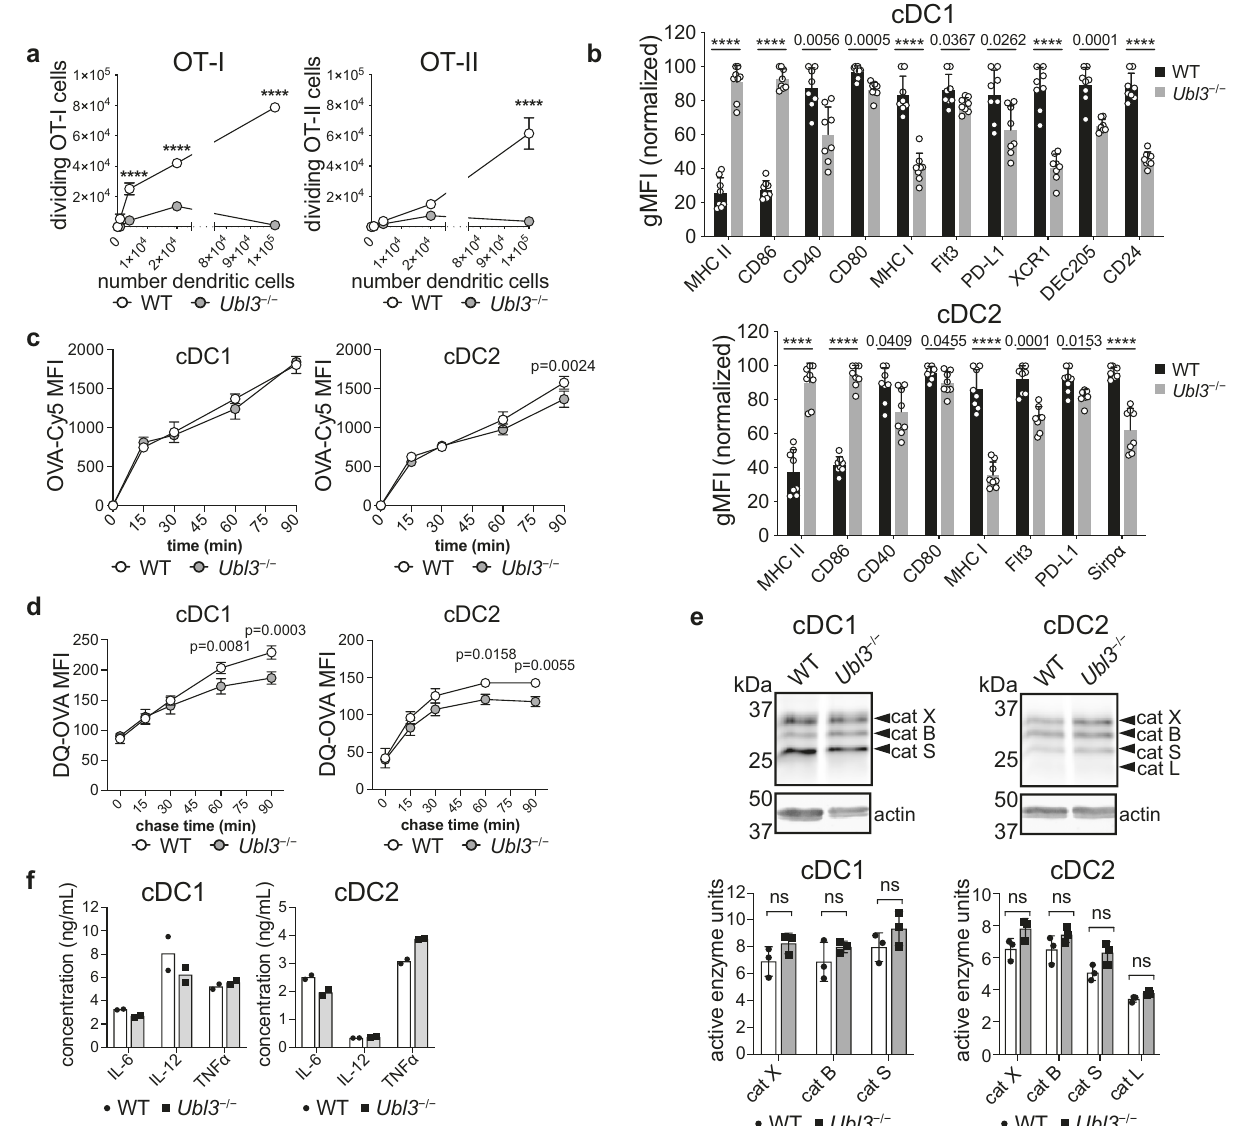
Fig. 7 Lack of UBL3 alters cDC function and phenotype. a Ex vivo antigen presentation assay. WT and Ubl3 − / − mice were injected with 1 µ g of anti- CLEC9A-OVA mAb. Indicated numbers of spleen cDC1 and cDC2 were puri fi ed and co-cultured with OT-I or OT-II cells, and divided OT-I or OT-II cells enumerated by fl ow cytometry. Data with n = 3, representative of two experiments, mean ± SD, **** p < 0.0001, two-way ANOVA with Bonferroni ’ s